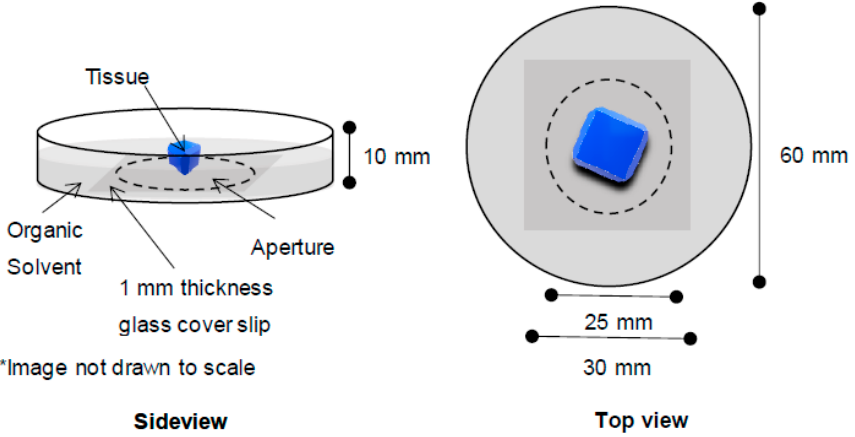
Figure 5. Imaging chamber for cleared tissues using inverted confocal microscopy. Epoxy glue was used to adhere the glass cover slip to the bottom of the glass dish. The epoxy glue resisted erosion from organic solvents in the tested duration (72 h). Not drawn to scale.